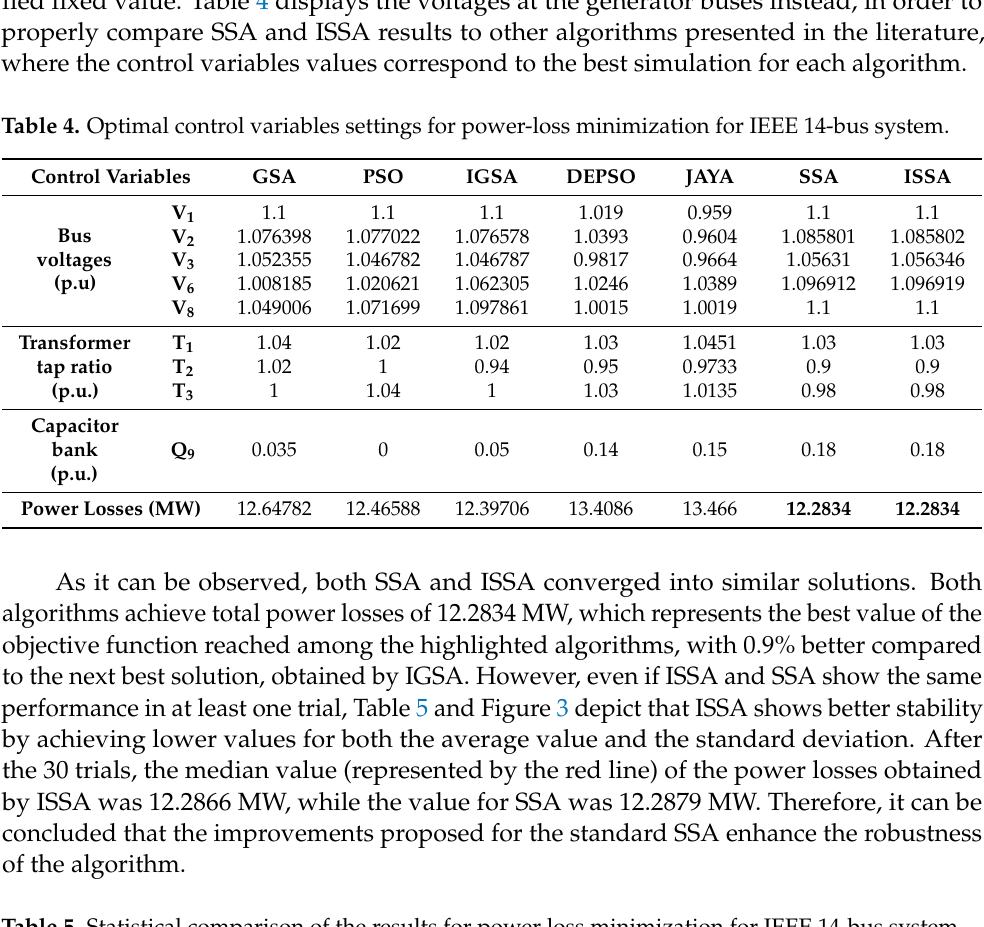
Table 5. Statistical comparison of the results for power loss minimization for IEEE 14-bus